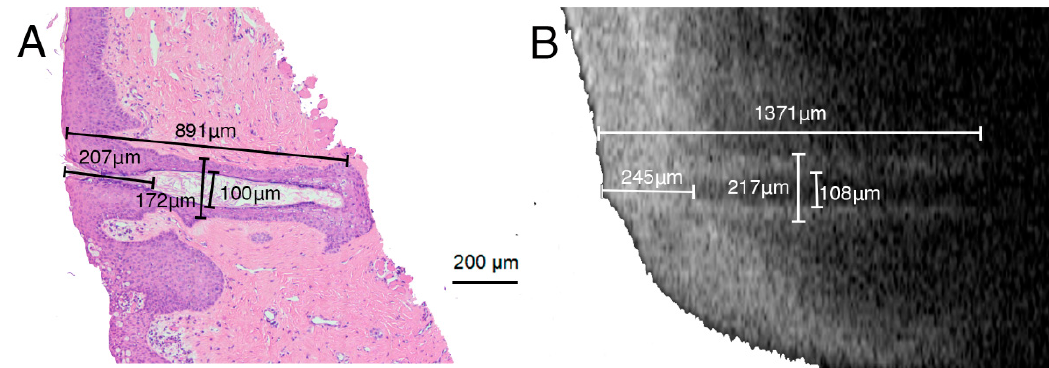
Figure 2. Comparison of ( A ) a photomicrograph of hematoxylin and eosin (H&E)-stained eyelid margin tissues and ( B ) anterior segment optical coherence tomography (OCT) image and showing the meibomian gland opening structures.